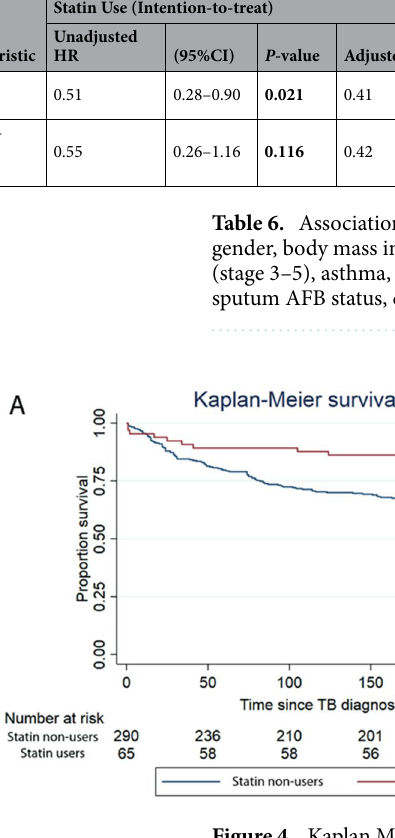
Figure 4. Kaplan Meier analysis on the association of statin use among patients with Atherosclerotic cardiovascular disease (ASCVD) with ( A ) all-cause mortality and ( B ) infection-related mortality.